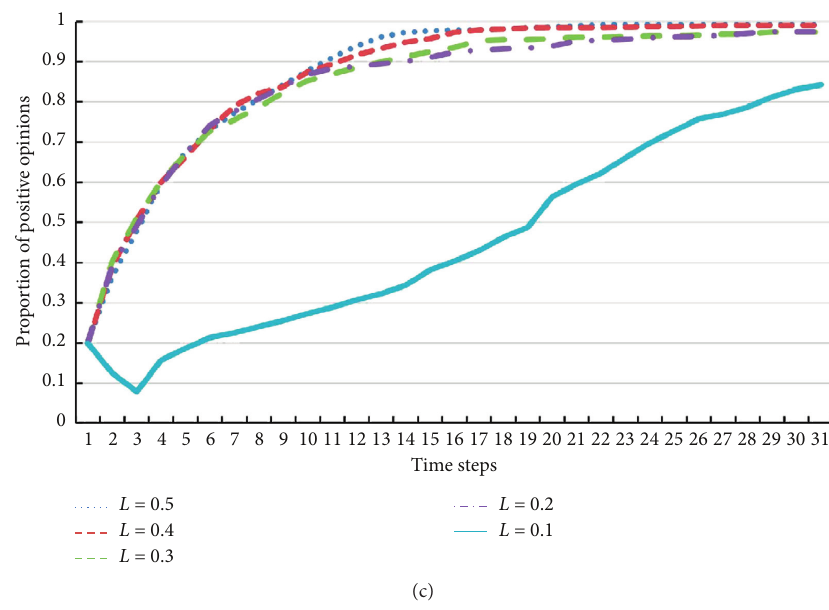
Figure 4: The evolution trends for the initial proportion pp � 0 . 2, opinion control levels k � 1 , 3 , and 5, and L � 0 . 5 , 0 . 4 , 0 . 3 , 0 . 2 , and 0 . 1 in � 20 and m � 5. (a) The initial proportion pp � 0.2, C � 2, and L � 0.5, 0.4, 0.3, 0.2, and 0.1. (b) The initial scale-free networks with m 0 proportion pp � 0.2, C � 6, and L � 0.5, 0.4, 0.3, 0.2, and 0.1. (c) The initial proportion pp � 0.2, C � 10, and L � 0.5, 0.4, 0.3, 0.2, and